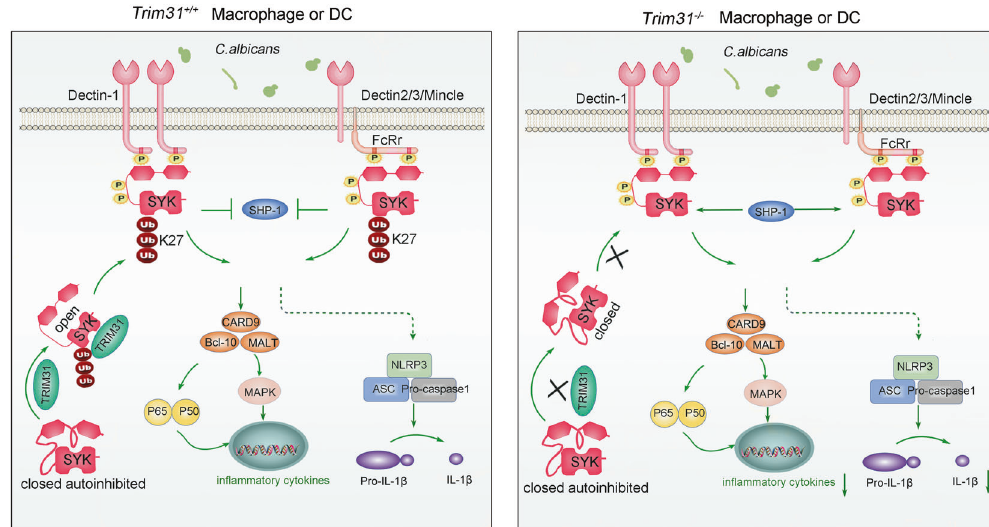
Fig. 8 A hypothetical model of the role of TRIM31 in anti-fungal immunity response. TRIM31 catalyzes the K27-linked polyubiquitination of SYK, which can disrupt the autoinhibited status of SYK, promote SYK binding to CLRs, decrease the association of SYK and SHP-1, leading to the increased SYK kinase activity (left). TRIM31 de fi ciency leads less SYK translocation to the membrane, produces lower amounts of pro- in fl ammatory cytokines and chemokine in response to C. albicans infection